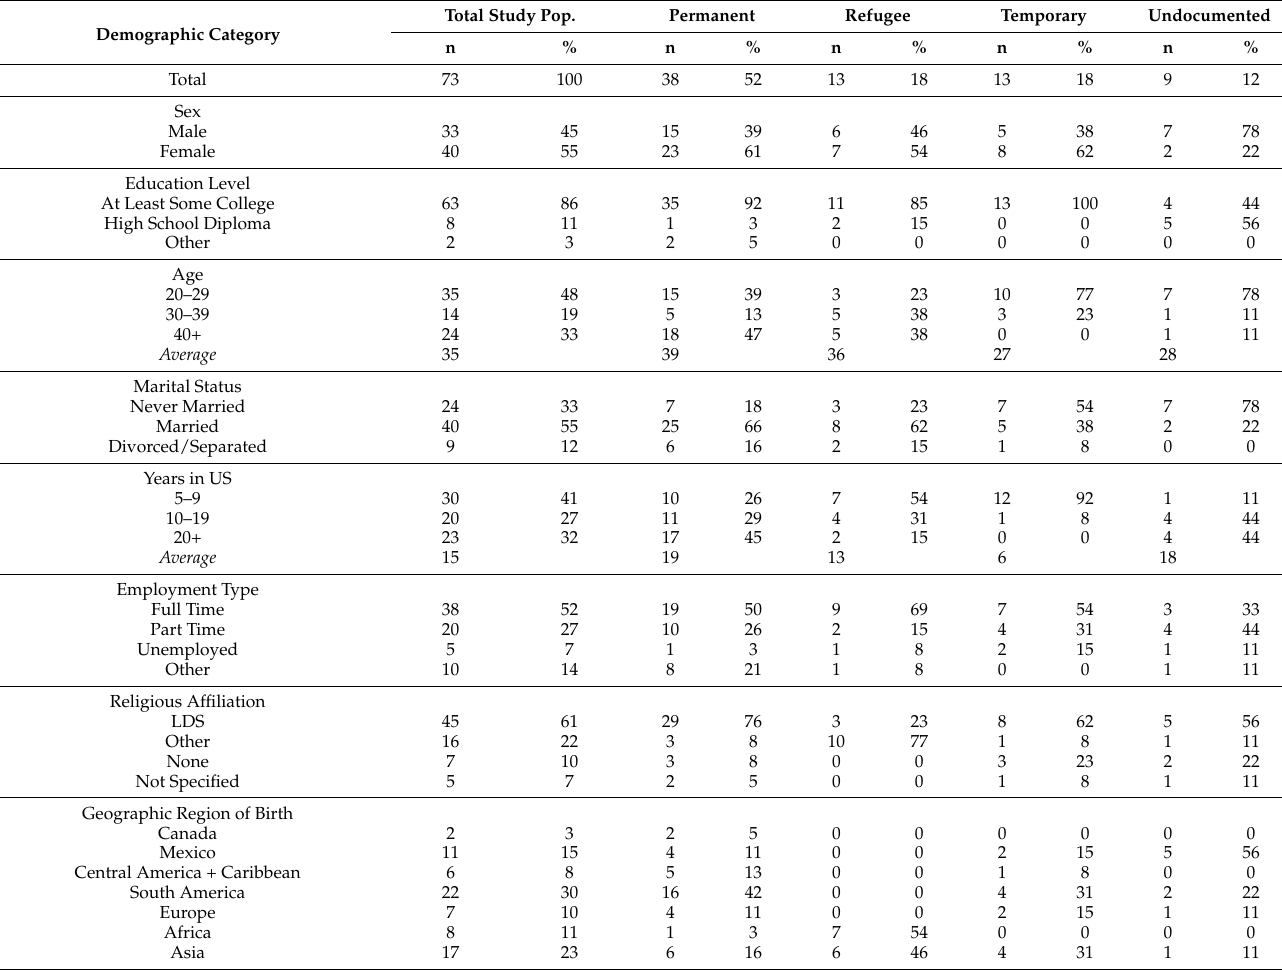
Table 1. Summary of Interviewee Demographic Information by Migration